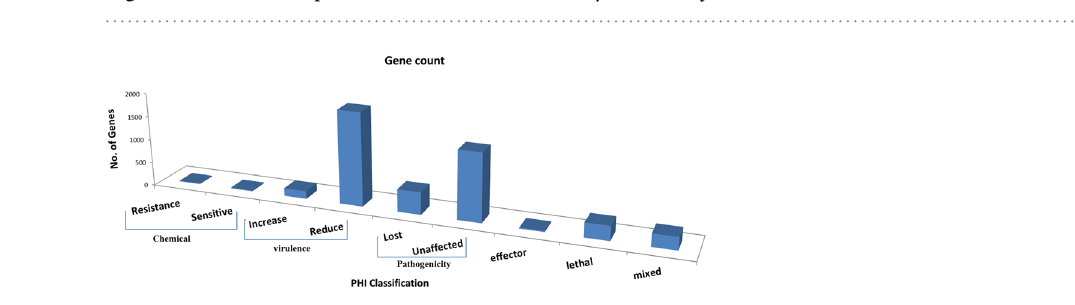
Figure 5. Schematic representation of Secretome Analysis in A. rolfsii .